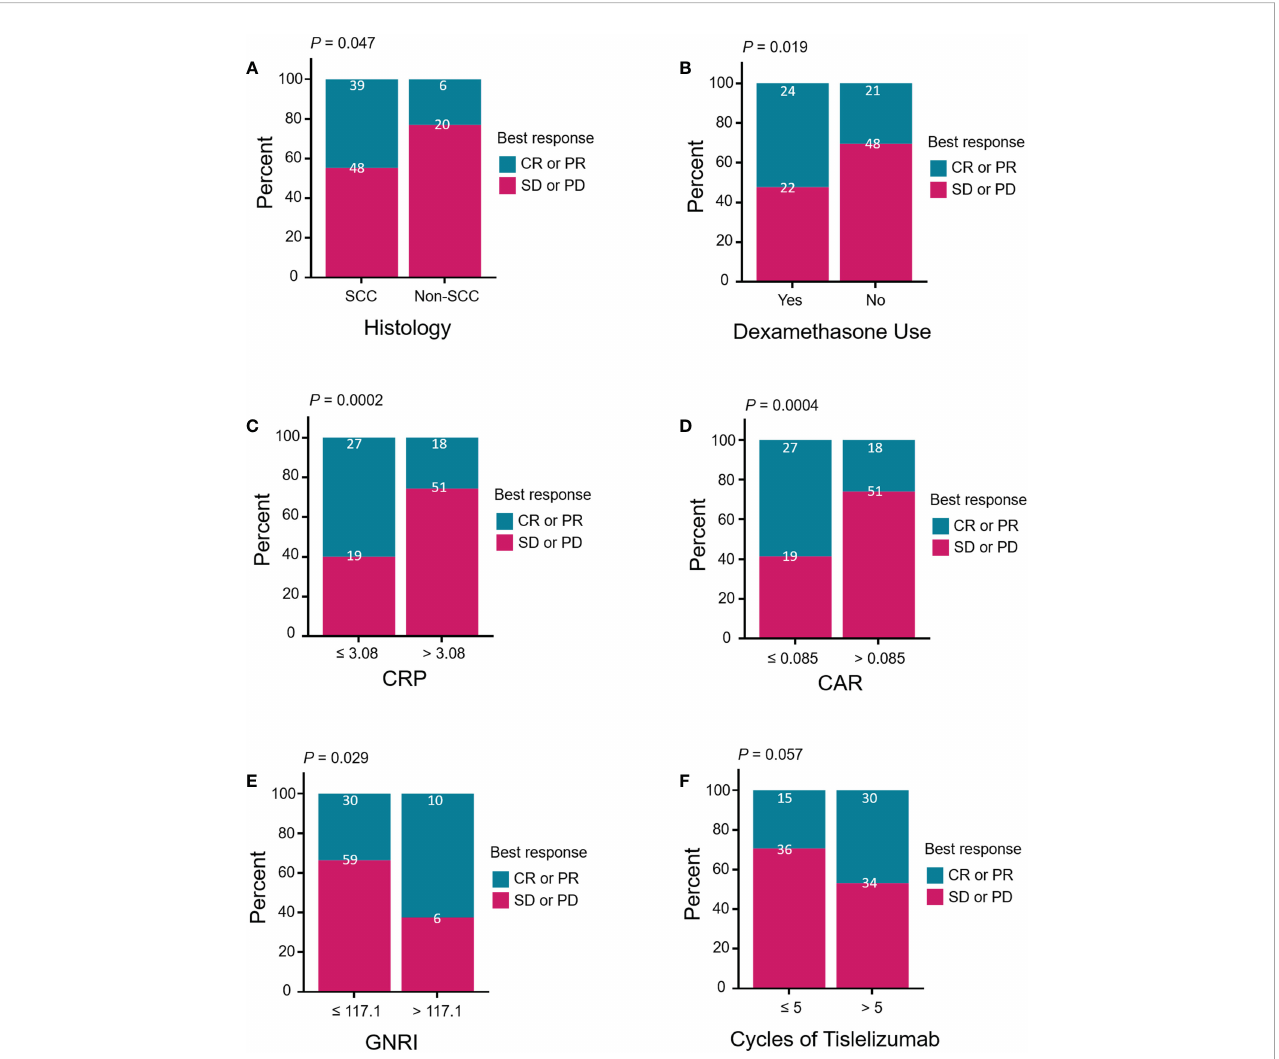
FIGURE 3 Treatment response of patients strati fi ed by (A) histology (squamous vs. non-squamous), (B) dexamethasone use (yes vs. no), (C) CRP ( ≤ 3.08 vs. > 3.08, mg/L), (D) CAR ( ≤ 0.085 vs. > 0.085), (E) GNRI ( ≤ 117.1 vs. > 117.1), and (F) cycles of tislelizumab ( ≤ 5 vs. > 5). Treatment response was divided by CR or PR (blue group) versus SD or PD (red group). Pearson ’ s chi-square test and Fisher ’ s exact test were performed to determine the relationships between the above clinical characteristics and treatment response. CR, complete response; PR, partial response; SD, stable disease; PD, progressive disease; SSC, squamous cell carcinoma; CRP, C-reactive protein; CAR, CRP-to-albumin ratio; GNRI, geriatric nutritional risk index.